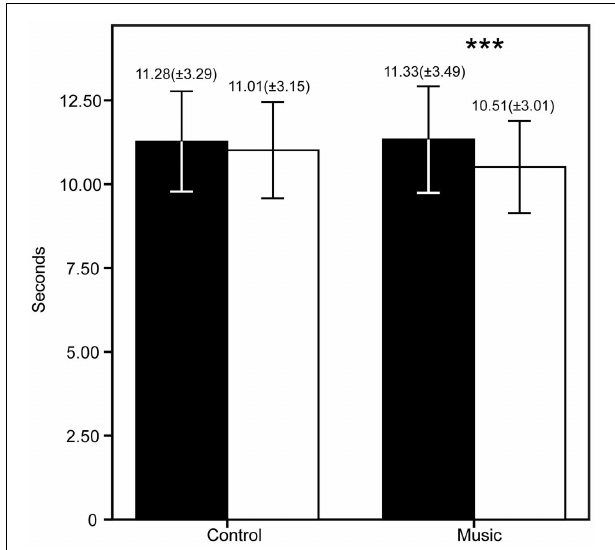
FIGURE 3 | Results of the timed up and go task (TUG) before and after the control/music conditions. The bars represent the mean of each measure, whereas the error bars represent the standard deviation. Above the error bars we show the Mean ( SD ) for each measure. ∗∗∗ p < 0 . 006.